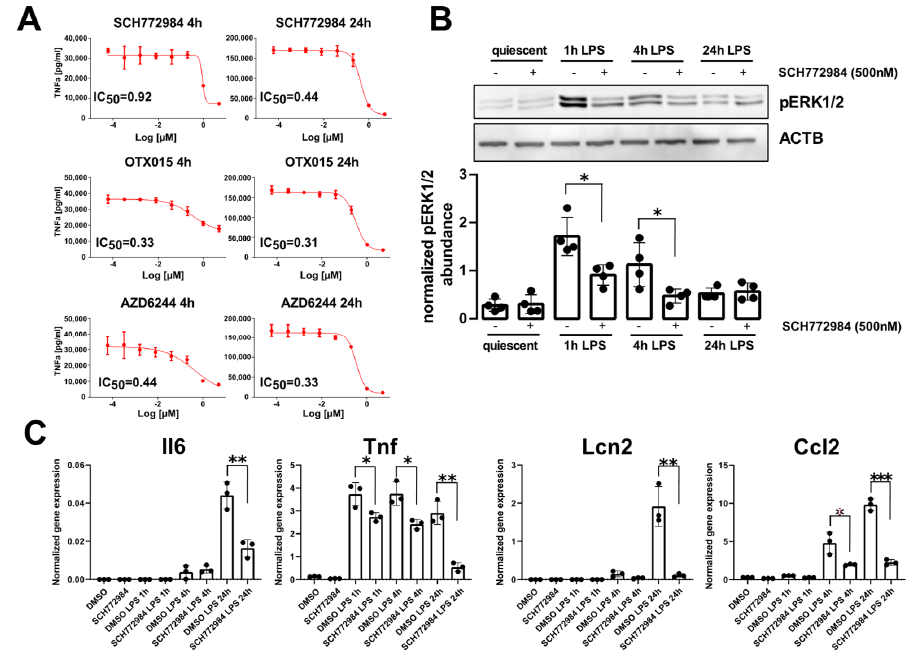
Figure 1. SCH772984 significantly attenuates LPS-induced TNFa production and inflammatory genes expression in the RAW 264.7 cell line. ( A ) IC 50 values of TNFa production inhibition for the most effective drugs at 4 h and 24 h post-LPS challenge. ( B ) Representative Western blot (upper panel) showing the levels of ERK1/2 phosphorylation following SCH772984 treatment upon LPS time course challenge. The graph (lower panel) shows the averaged pERK1/2 abundance normalized to Actb by densitometry analysis of Western blotting bands. Values derived from four independent experiments and their means (+/ − SD) are presented. * p ≤ 0.05, as determined by unpaired t -test. ( C ) qPCR results showing the mRNA expression of inflammatory genes following SCH772984 treatment upon LPS time course. Data from three independent experiments and their means and +/ − SD are presented. * p ≤ 0.05, ** p < 0.01, *** p < 0.001 as determined by unpaired t